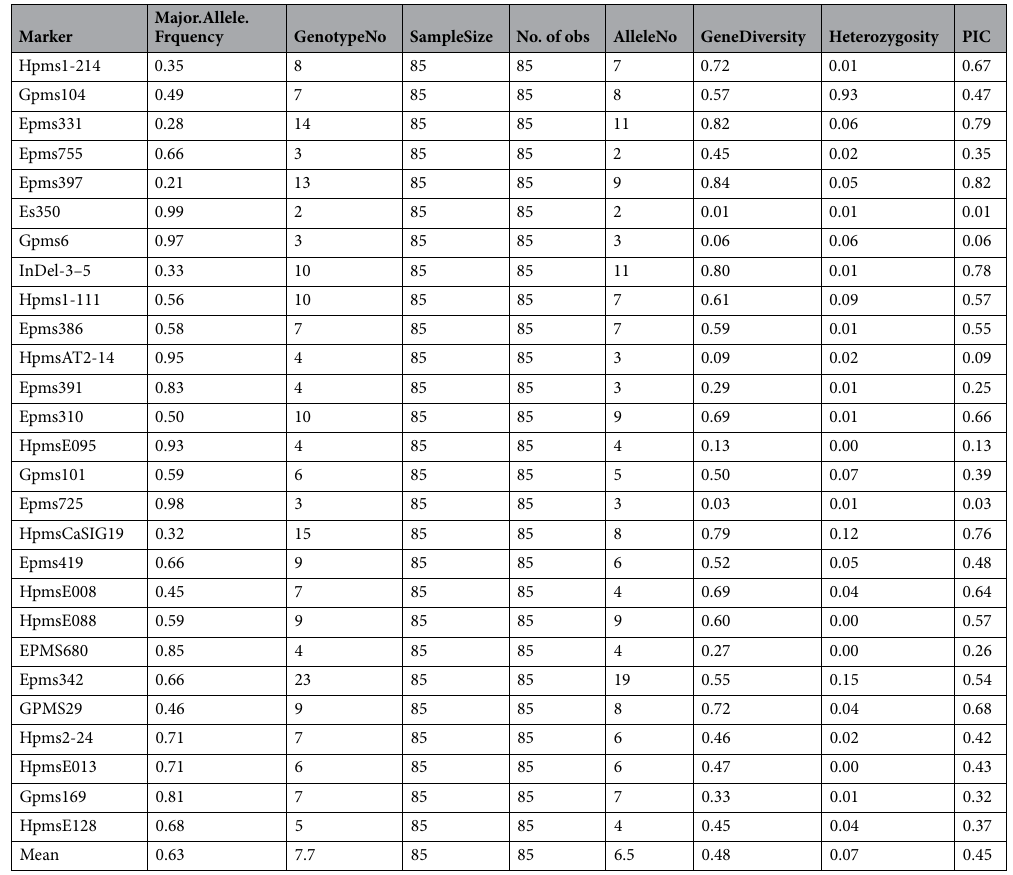
Table 5. Genetic diversity analysis of 85 current breeding lines at 26 polymorphic simple sequence repeat (SSR) loci and 1 insertion-deletion (InDel)